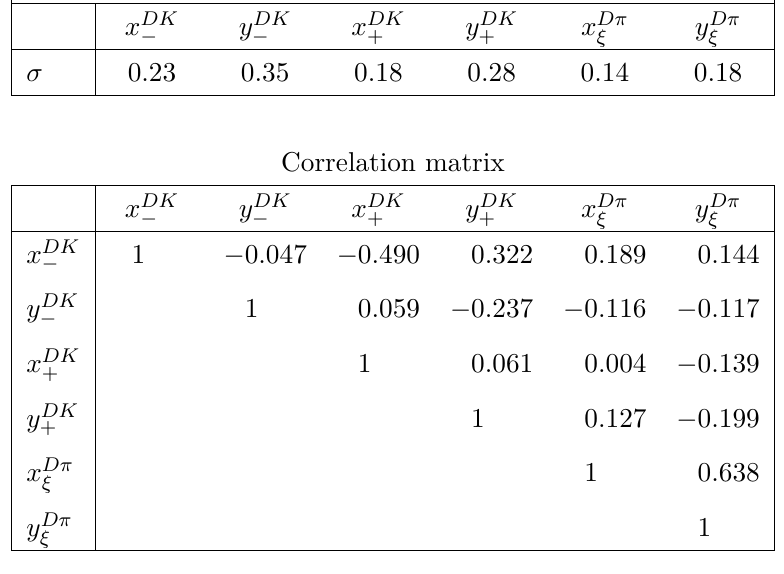
, y DK , x Dπ , and y Dπ due to strong-phase inputs, ± ± ξ ξ